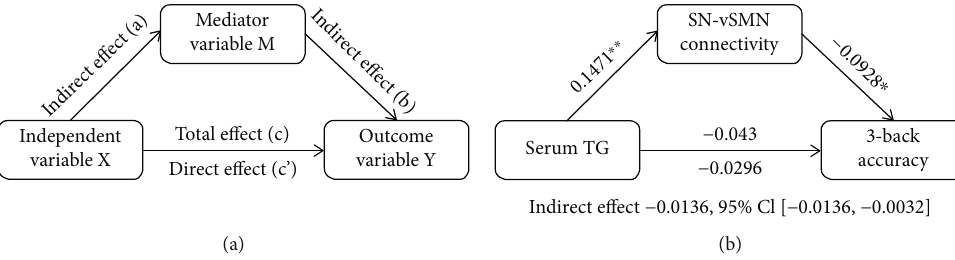
Figure 4: Conceptual diagram of mediation analysis. (a) Graphical representation of a mediation analysis model with one mediator. Total effect of X on Y ð c Þ = indirecteffect of X on Y through M ð a × b Þ + direct effect of X on Y ð c ′ Þ . (b) The mediation analysis between serum TG level ( X ) and 3-back accuracy ( Y ), with SN-vSMN connectivity as the mediator (M). Path coe ffi cients with P values ( ∗ P < 0 : 05 and ∗∗ P < 0 : 01 , respectively). Abbreviations: TG: triglyceride; SN: salience network; vSMN: ventral sensorimotor